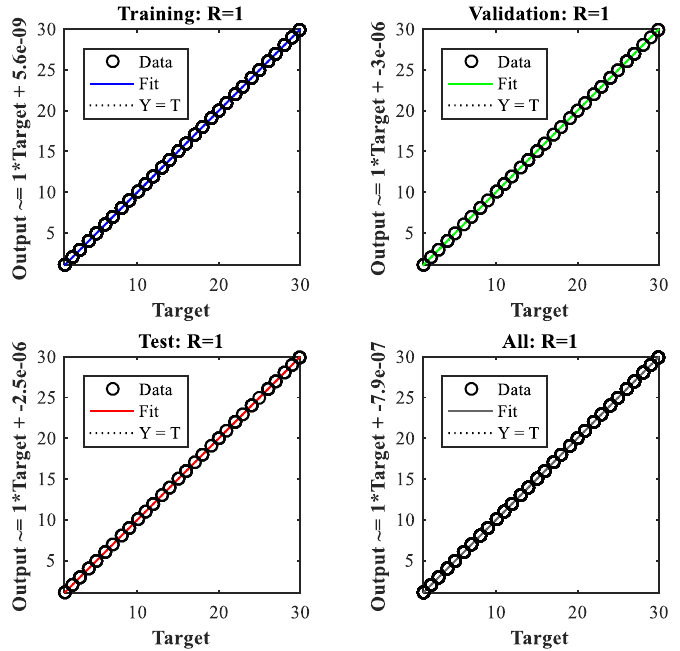
Figure 13. Regression of the training, validation, and test of the neural network.